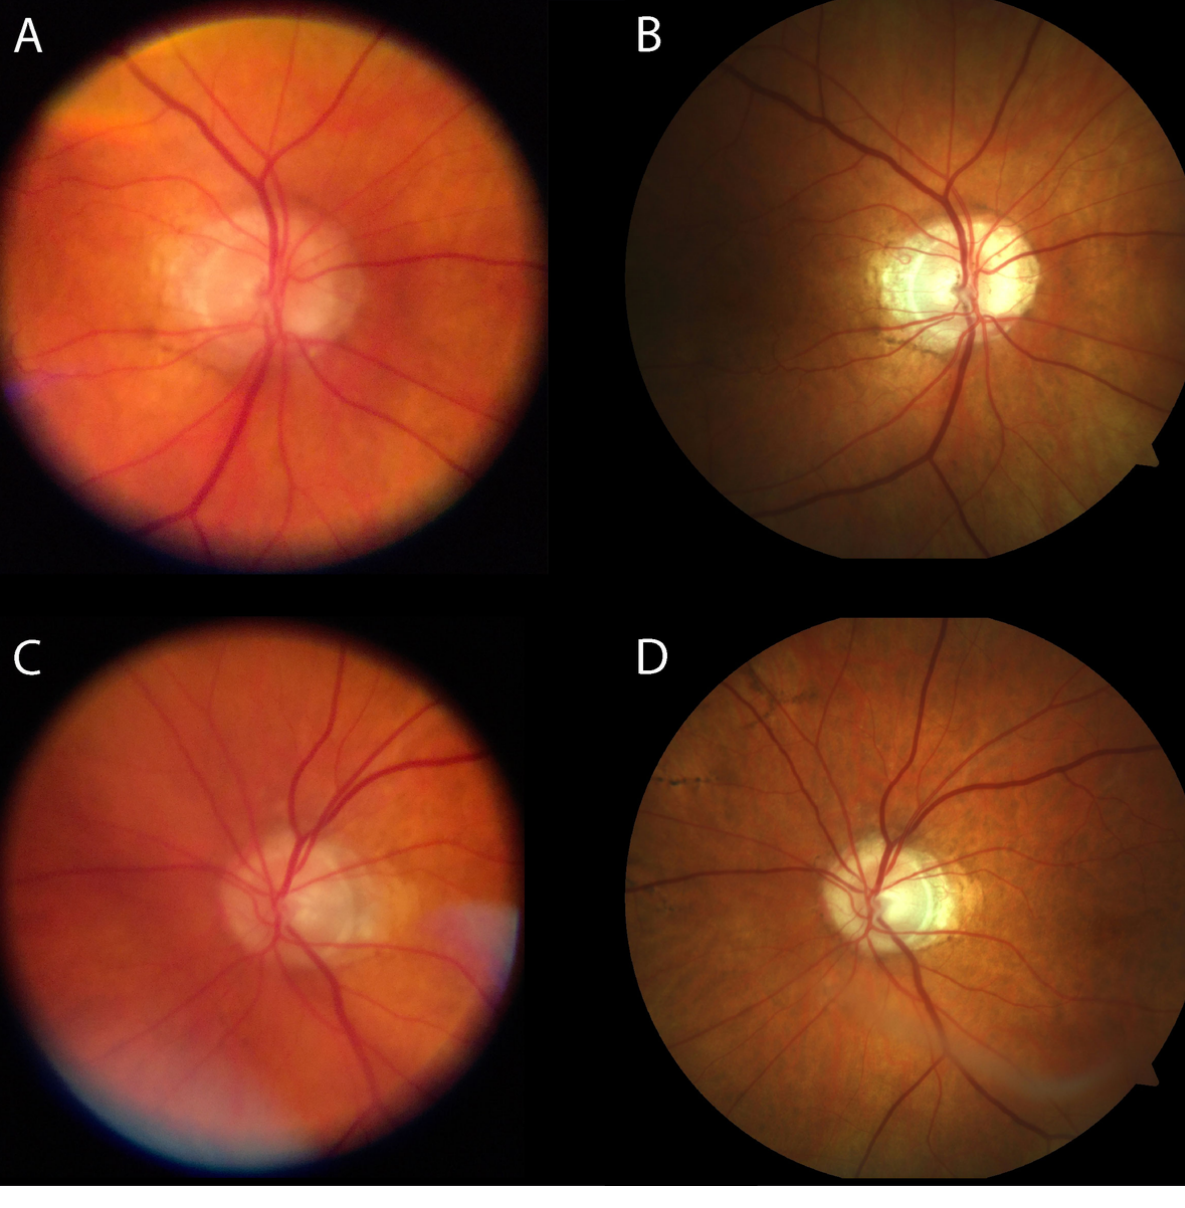
Figure 3. Exemplary comparison of smartphone-based fundus imaging and conventional fundus imaging. Exemplary comparison of two eyes (A+B and C+D) which were both imaged with smartphone-based fundus imaging (A and C) and conventional fundus imaging (B and